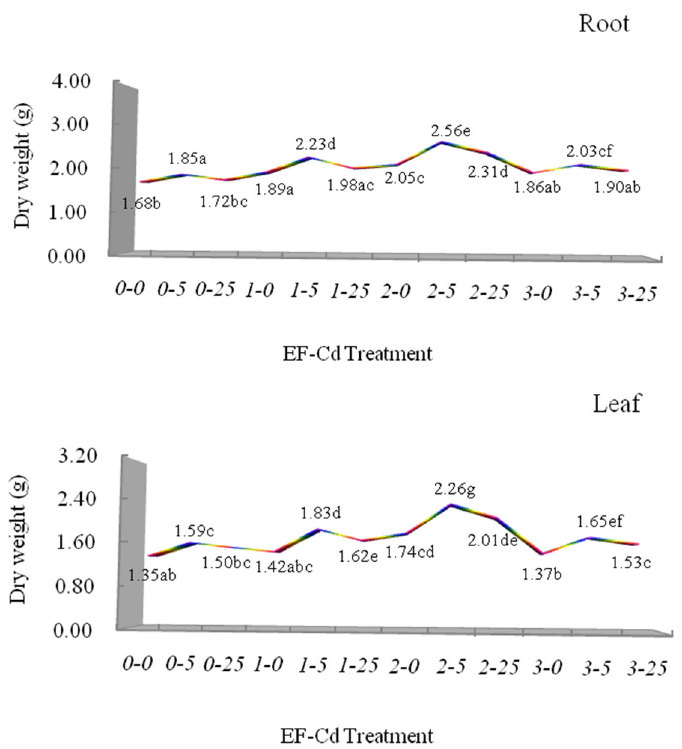
Figure 2. Effects of different EF-Cd treatments on dry weight of root and leaf biomass in L. japonica . Different colors showed the different responses in L. japonica under EF-Cd treatments. Different letters indicate significant differences at the p < 0.05 level. Values represent mean ± SD.